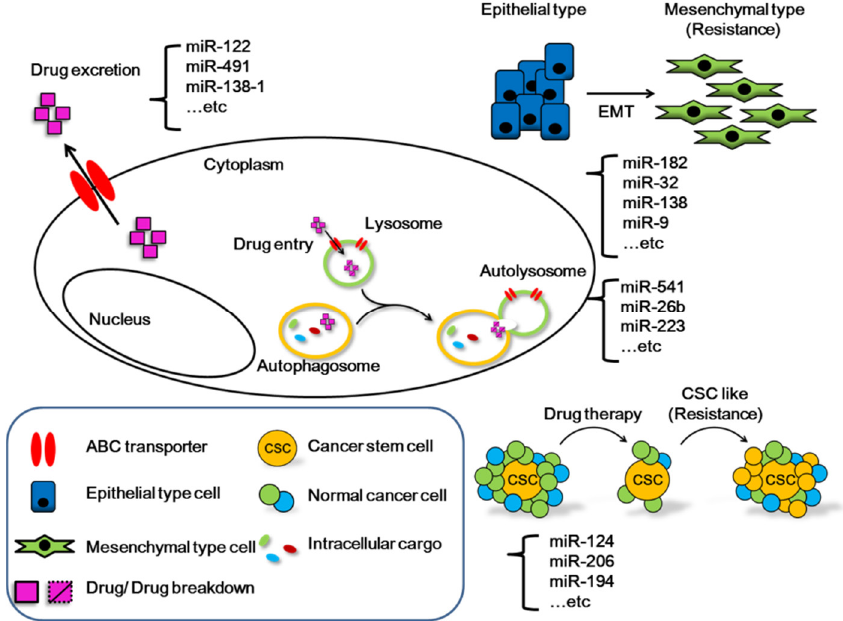
Figure 2. Mechanisms of action of the microRNAs involved in drug resistance of HCC cells. In HCC cells, miRNAs are widely involved in various mechanisms related to drug resistance through elimination of drugs from the ABC transporters in the cell, lysosomes and autophagy that degrade drugs within the cell, or EMT and CSC that directly affect cell morphology.